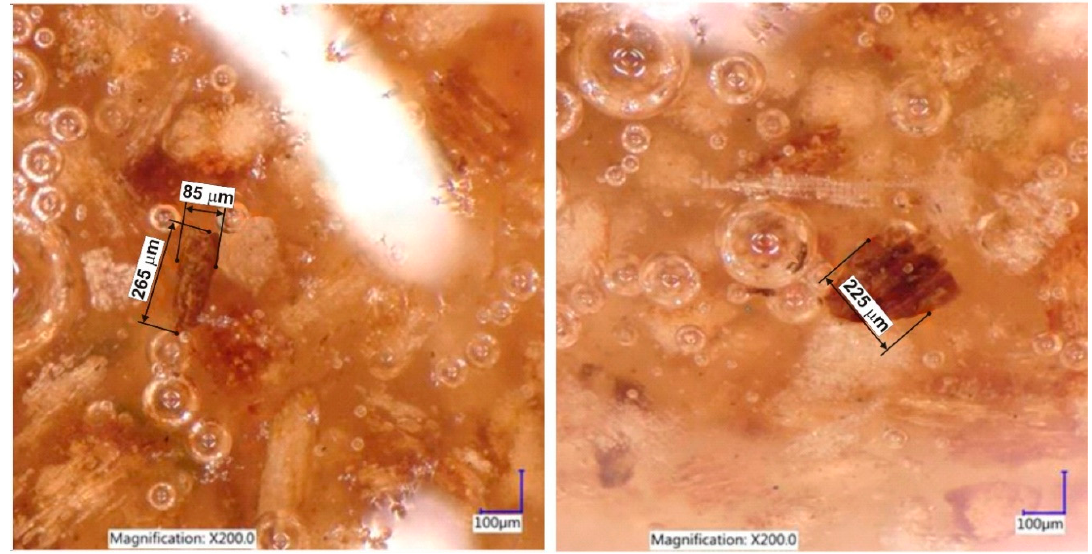
Figure 4. The particles of ground bark scattered in the adhesive mixture.